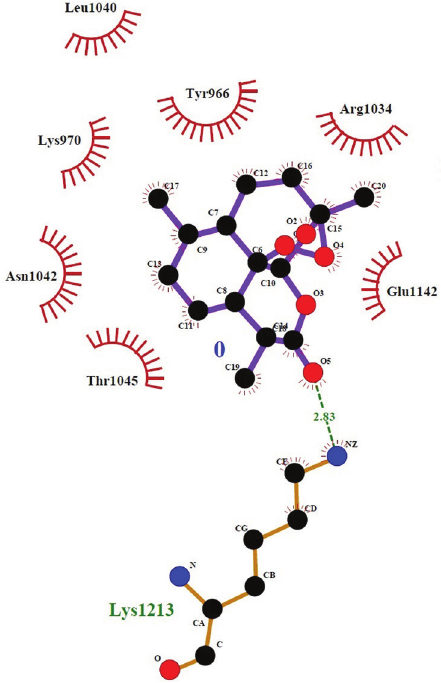
FIGURE 7 - Artemisinin docking pocket.